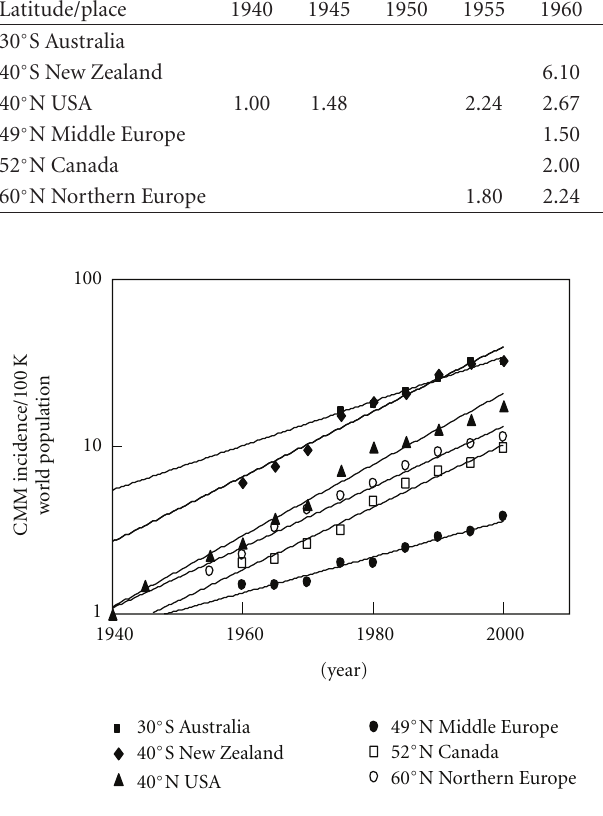
Figure 1: Temporal exponential increase in the incidence of CMM by latitude worldwide. Note that only New Zealand (40 ◦ S) and Northern Europe (60 ◦ N) have linear rates of increase.